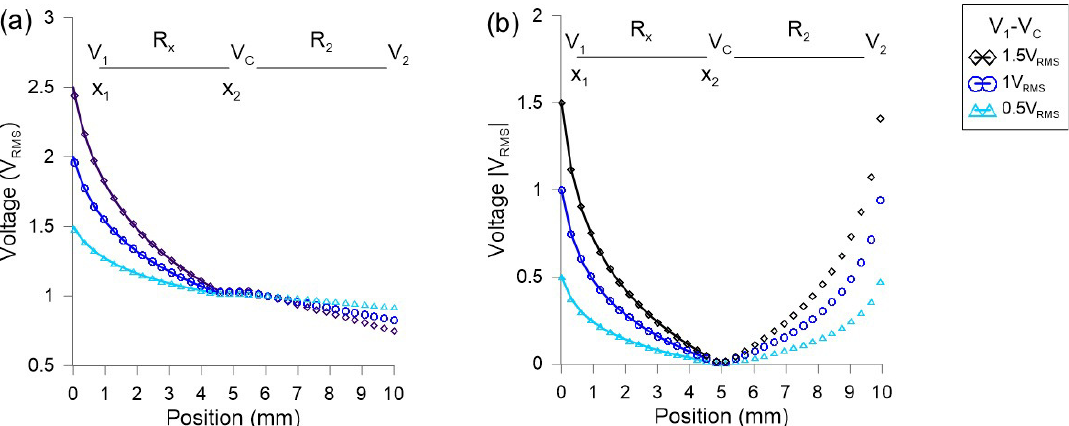
Figure 7. Simulation of the voltage distribution across the pyramid-shaped transmission line for ( a ) voltage divider configuration and ( b ) orthogonal configuration. Dots are the numerical estimations and lines the results of Equation (9). Structural parameters can be found in References [52,54].